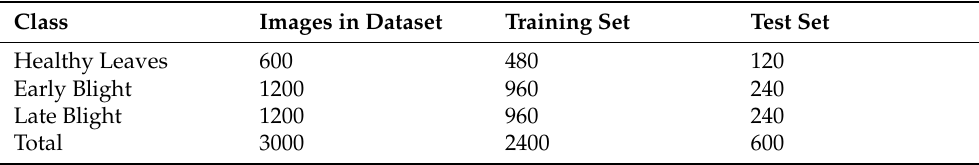
Table 2. List of categories included in the PlantVillage dataset without data augmentation. Class Images in